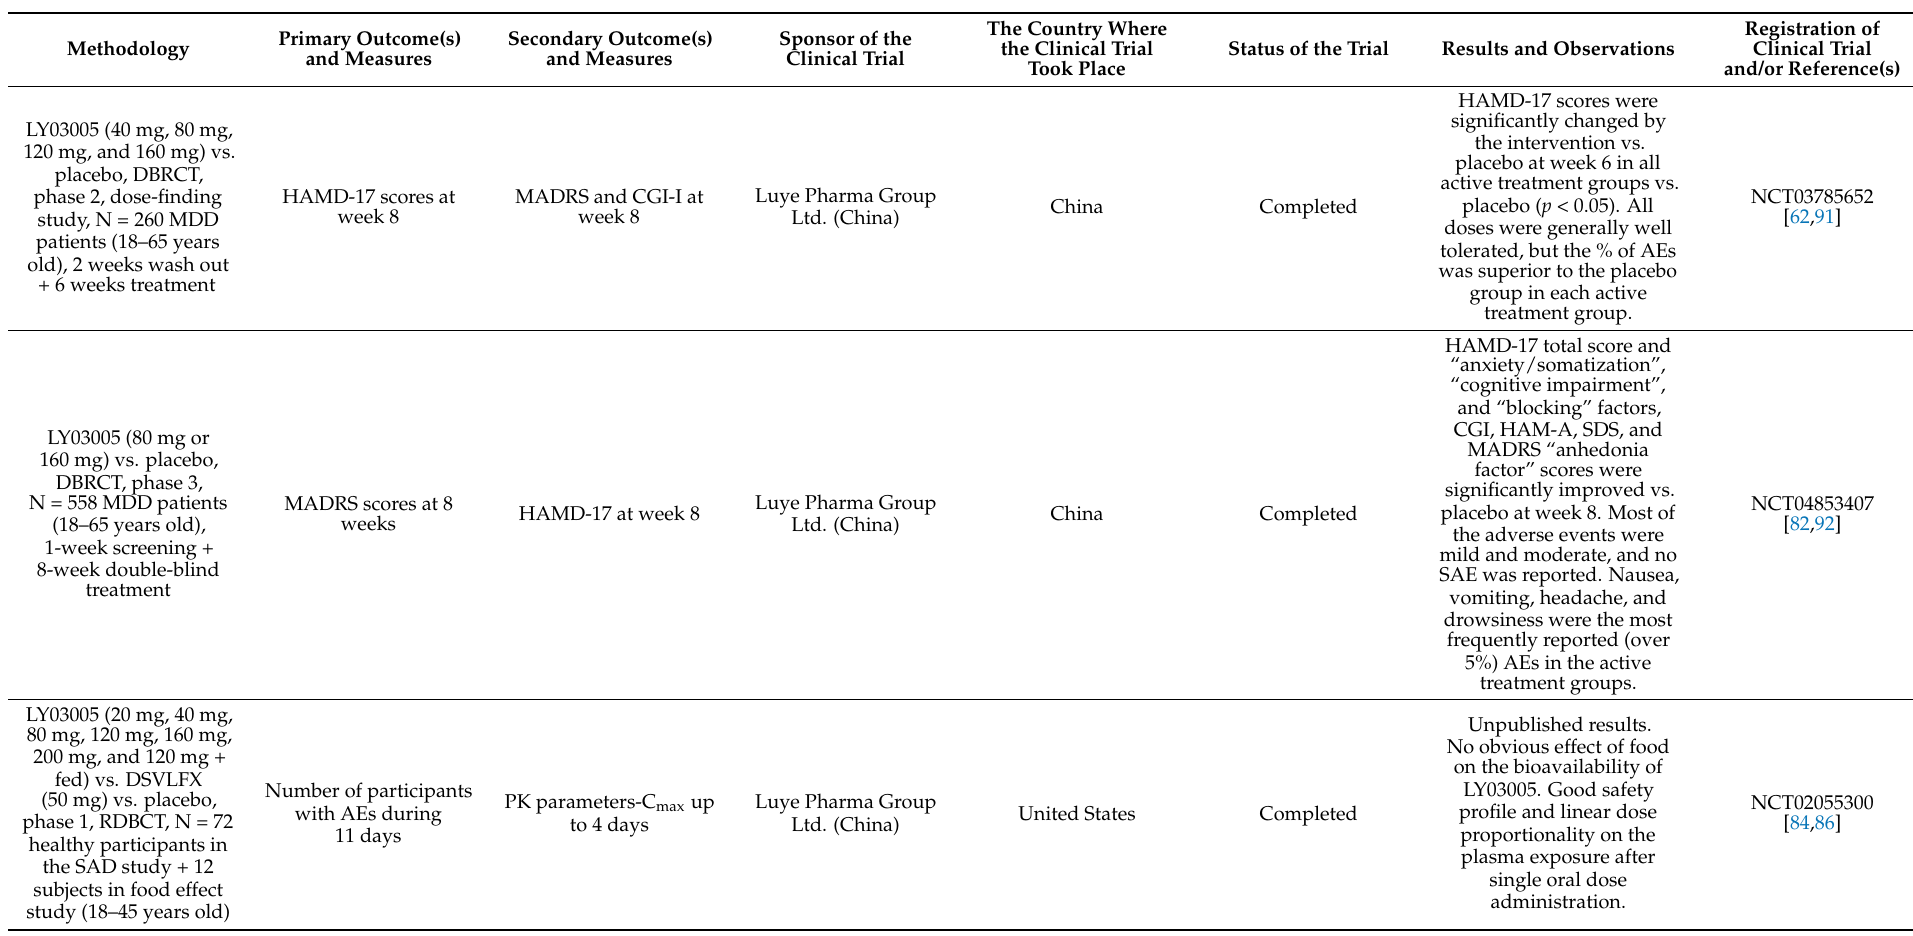
Table 2. Registered clinical trials exploring the efficacy and/or tolerability of toludesvenlafaxine